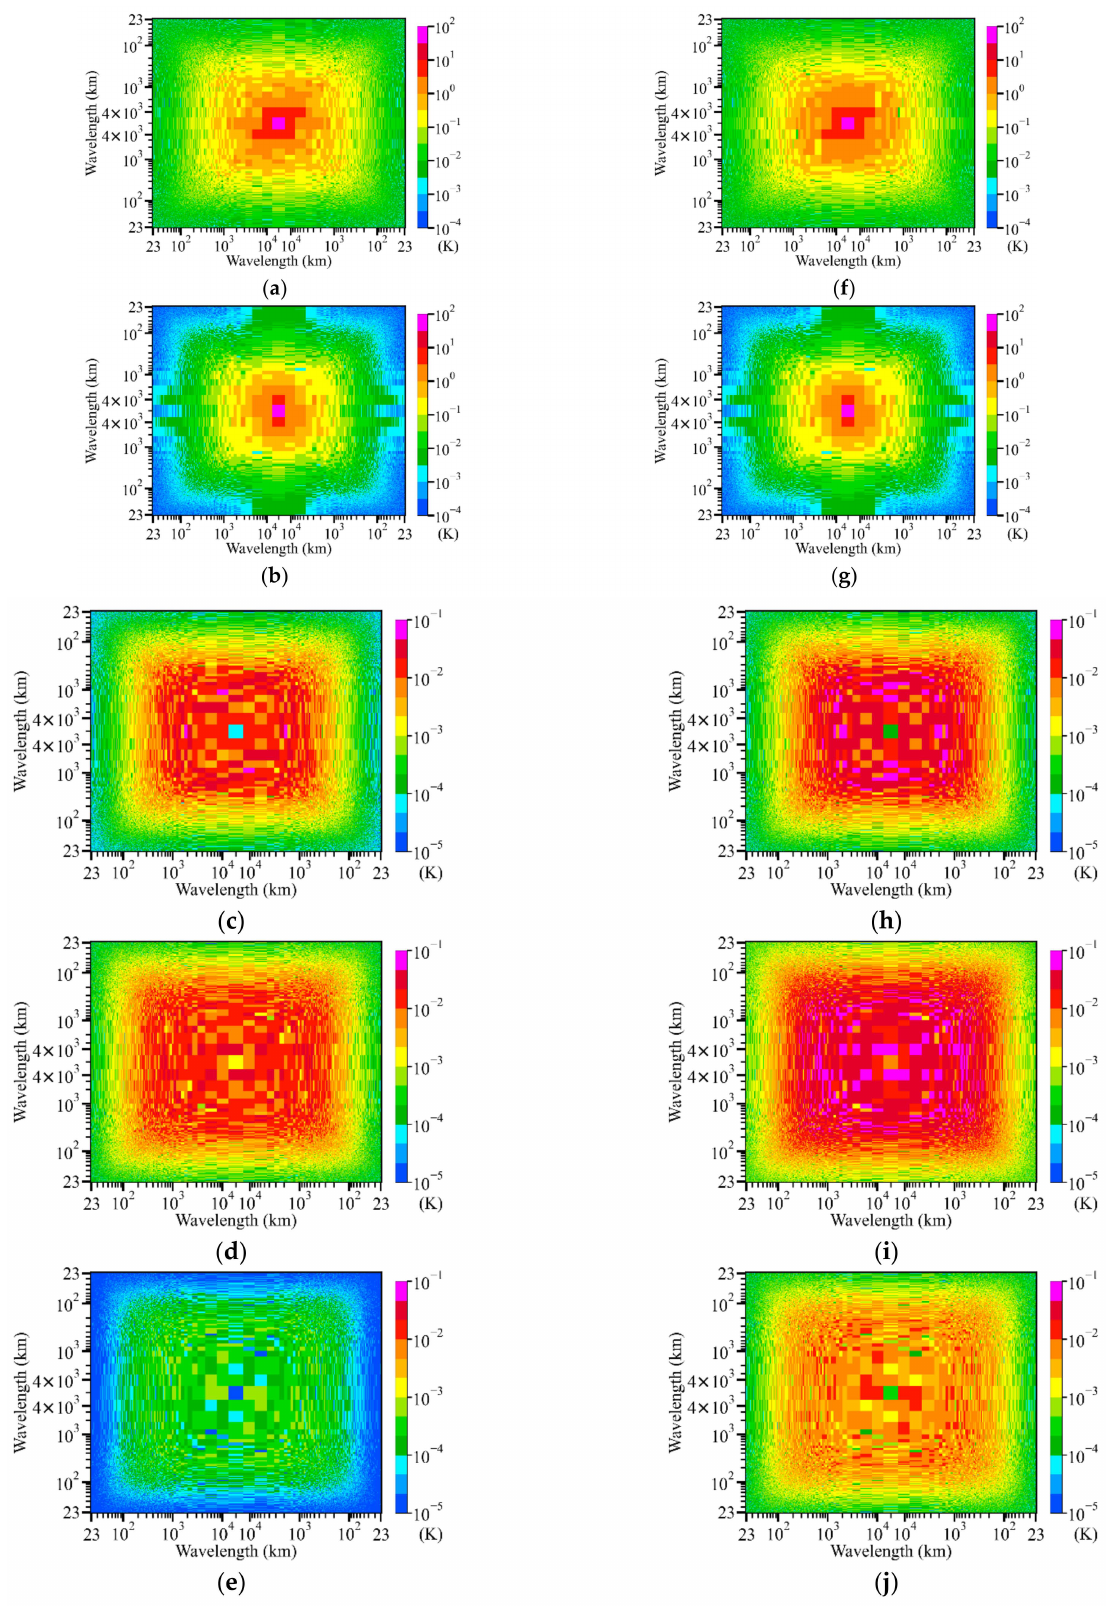
Figure 10. The two-dimensional spectra of ( a , f ) the AHI observations of brightness temperature, ( b , g ) the first, ( c , h ) the 20th, ( d , i ) the 40th, and ( e , j ) the 60th PCA components ( at 1600 UTC 10 May 2021 ( left panels) and 0300 UTC 11 May 2021 ( right